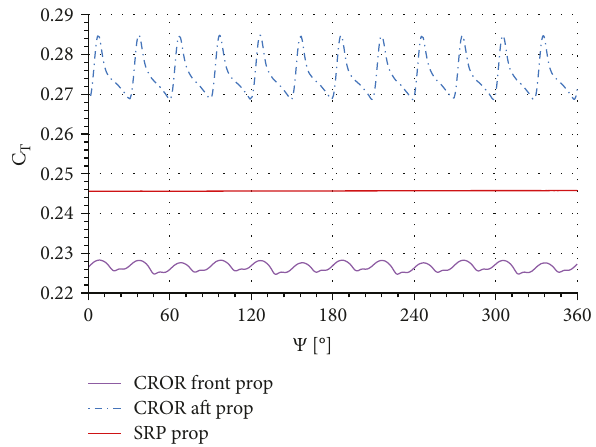
Figure 13: Comparison of SRP and CROR thrust coe ffi cient during one full rotation; J = 1 73779